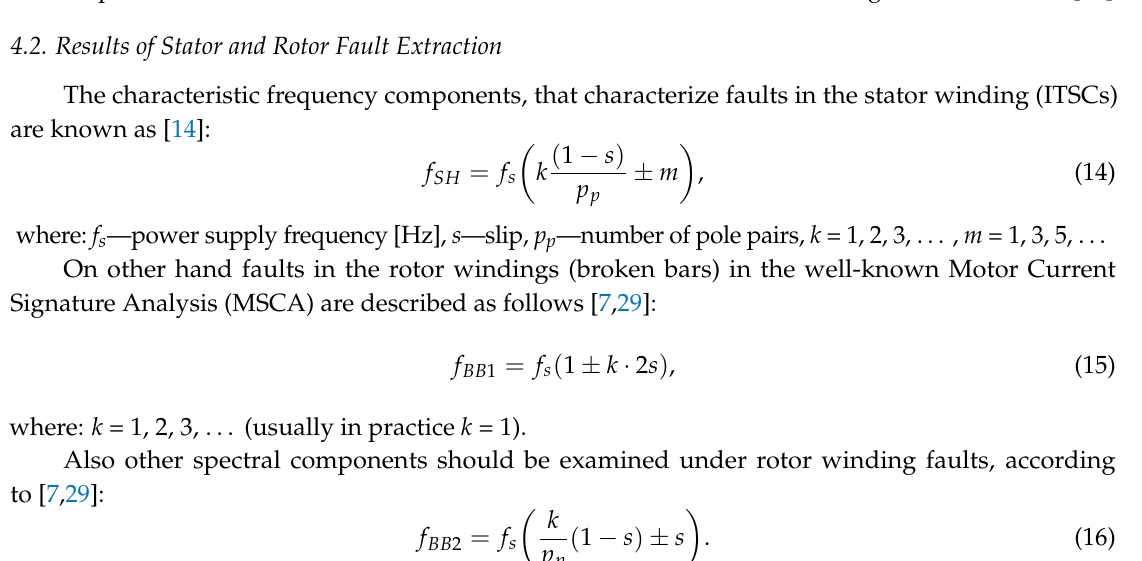
Figure 4. Illustration of the physical modelling of stator and rotor fault: ( a ) connection of the stator winding for inter-turn short-circuit modelling; ( b ) broken bars modelling in squirrel-cage rotor.